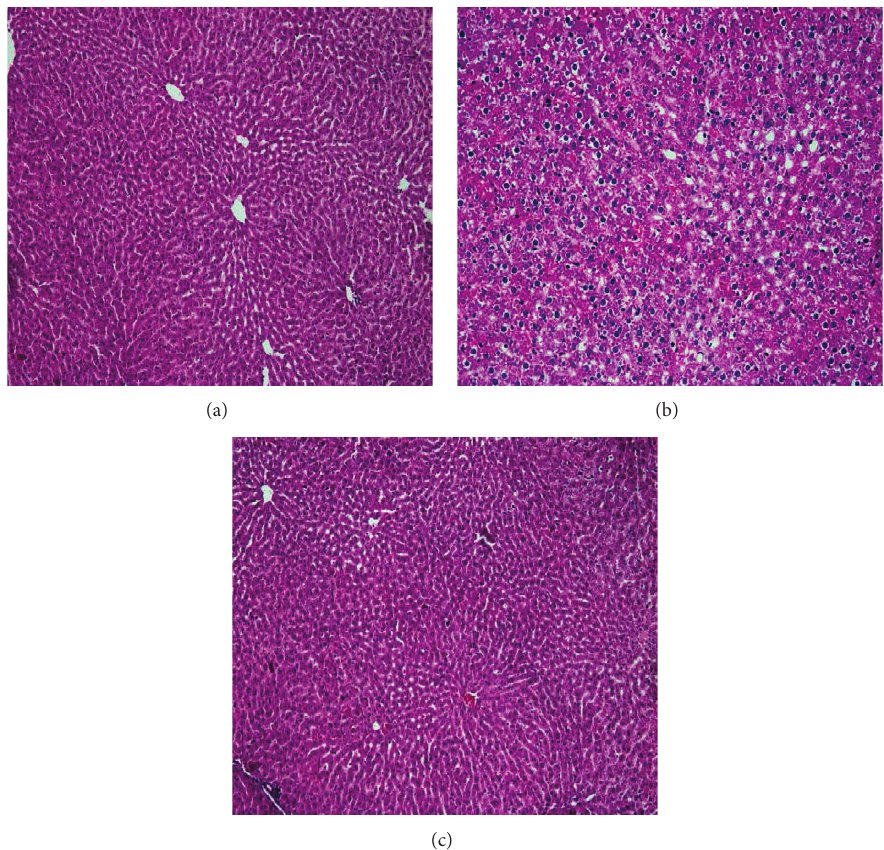
Figure 1: Hepatoprotective effect of IL-22 therapy against D-GalN/LPS-induced acute liver injury in rats. In comparison with livers of normal controlrats(a),after48 hfrominjectionofD-GalN/LPS,therewasseverehepaticinjurythatreflectedahighdegreeofhepatocellularnecrosis, apoptosis, and inflammatory cell infiltration (b); however, livers of rats injected with D-GalN/LPS and then treated with IL-22 (c) showed scant pathological foci and undetectable inflammatory cell infiltration. Table 1: Effects of IL-22 therapy on the survival rate and liver function serobiomarkers of rats 48 h after D-GalN/LPS injection. Groups AST (IU/L) ALT (IU/L) ALP (IU/L) TBILI (mg/dL) ALB (g/dL) Mortality (%) Control 105 ± 15.1 53.7 ± 8.9 211 ± 39.3 0.08 ± 0.01 4.4 ± 0.9 0 D-GalN/LPS 410 ± 45.8 ∗ D-GalN/LPS +